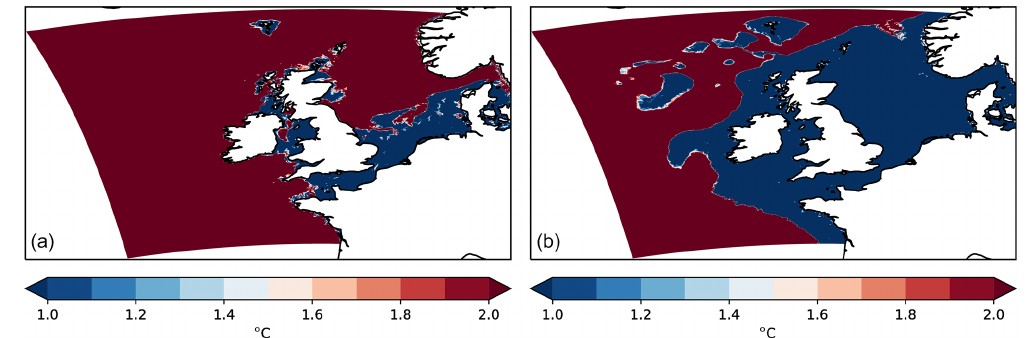
Figure 4. The top-to-bottom temperature difference at the end of summer ( a , 1 September 2017) and winter ( b , 1 March 2018) showing the extent of the domain where no balancing changes are applied to temperature or salinity when assimilating SSH (blue, where (cid:49)T < 1 ◦ C) and where the full balance is applied (red, where (cid:49)T > 2 ◦